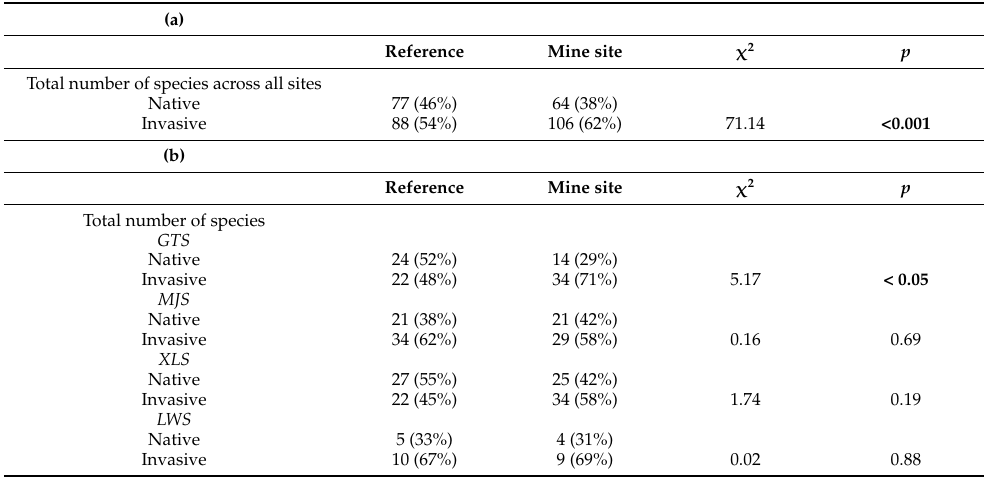
Table 3. Chi-square test results comparing the number of species of invasive versus native species: (a) across all sites, (b) among site pairs (mine sites and adjacent reference sites). Bold p -values indicate statistically significant differences.